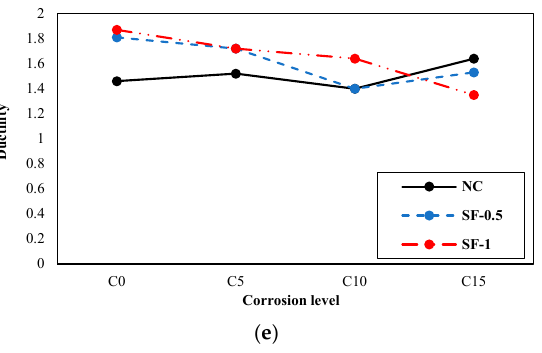
Figure 16. Changes in the studied characteristics with increasing corrosion levels: ( a ) bearing capacity, ( b ) midspan displacement, ( c ) energy absorption, ( d ) effective hardness, and ( e ) ductility. The diagrams show that the values of the investigated parameters for the bending behavior of the beam decreased with increasing corrosion levels for most of the speci- mens. The largest reductions in most beams occurred from 5% to 10% corrosion. However, the investigated structural behavior parameters increased in the specimens with steel fi- bers. There is a direct correlation between the increase in these values and the volume fraction of fibers used.